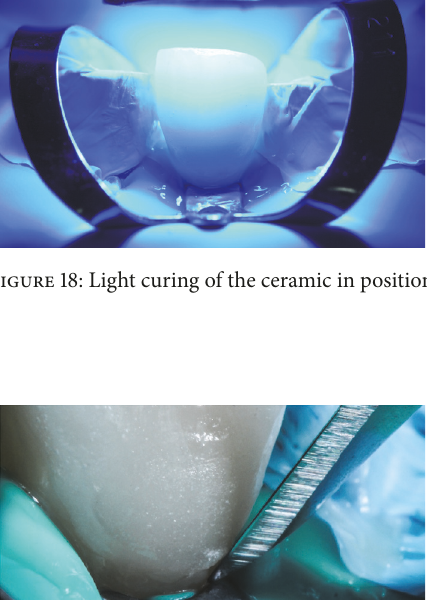
Figure 19: Magnified image showing the elimination of excesses with a number 11